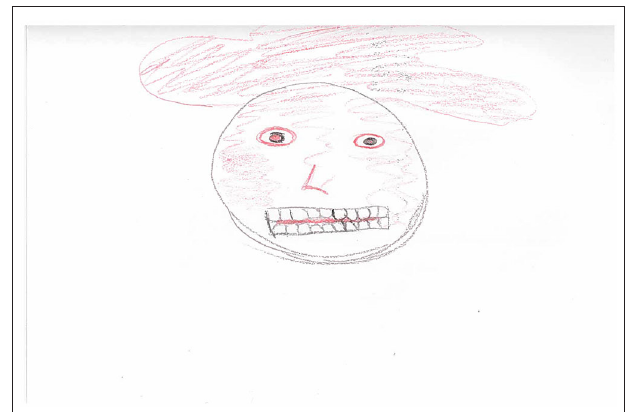
FIGURE 3 | WQ10 drawing of hatred and